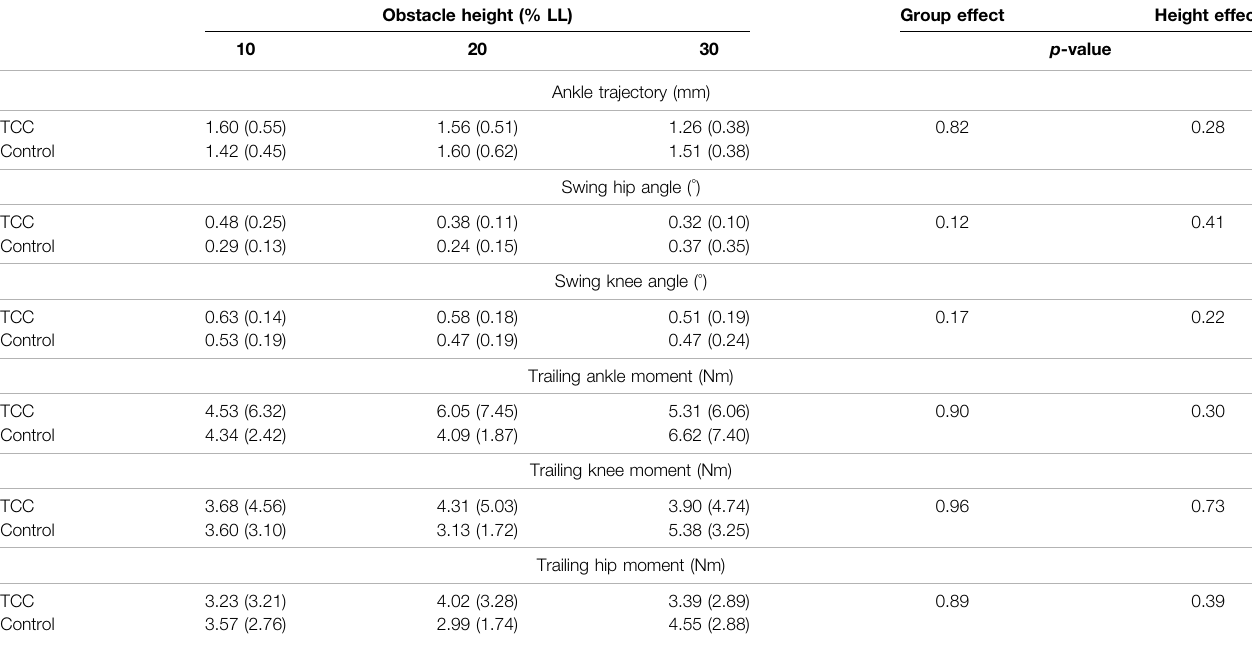
TABLE 2 | Means (standard deviations) of the RMSEs of the ankle trajectories and joint angles of the leading limb, and the joint moments of the trailing limb obtained by the MOOC with the best-compromise weighting set against the experimental data in the TCC and Control groups. Obstacle height (%